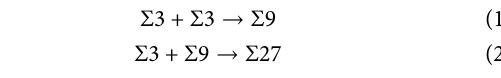
Frontiers in Materials |